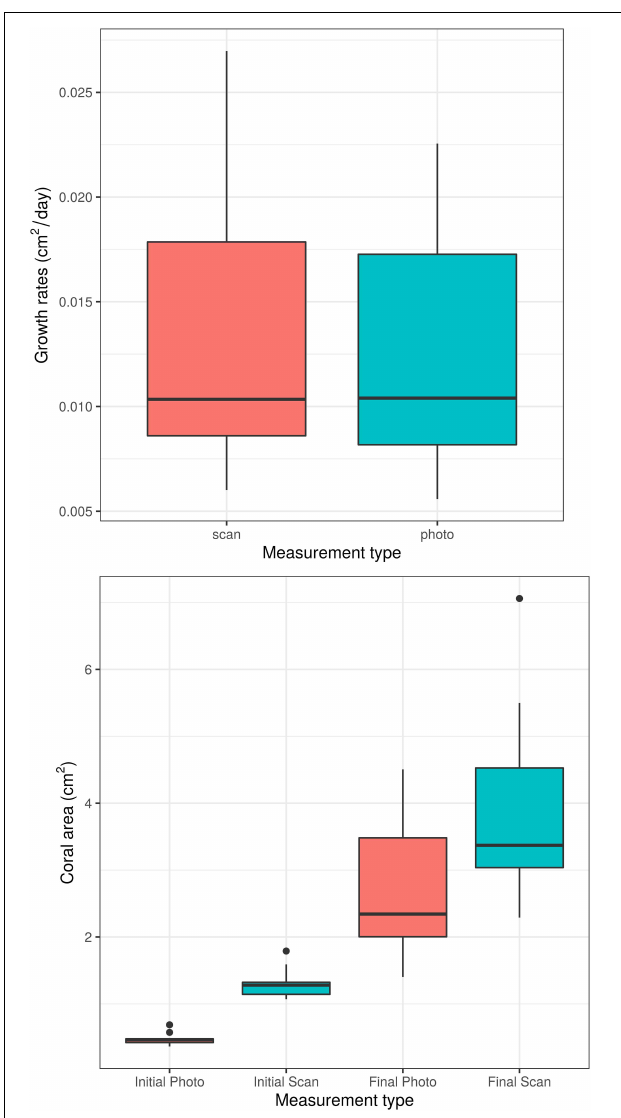
FIGURE 3 | Boxplots of daily coral growth rates (top) and of initial and final coral area (bottom) as measured by photo and 3D scanner. The two measurement methods do not significantly differ in their ability to measure coral growth ( p = 0.158).